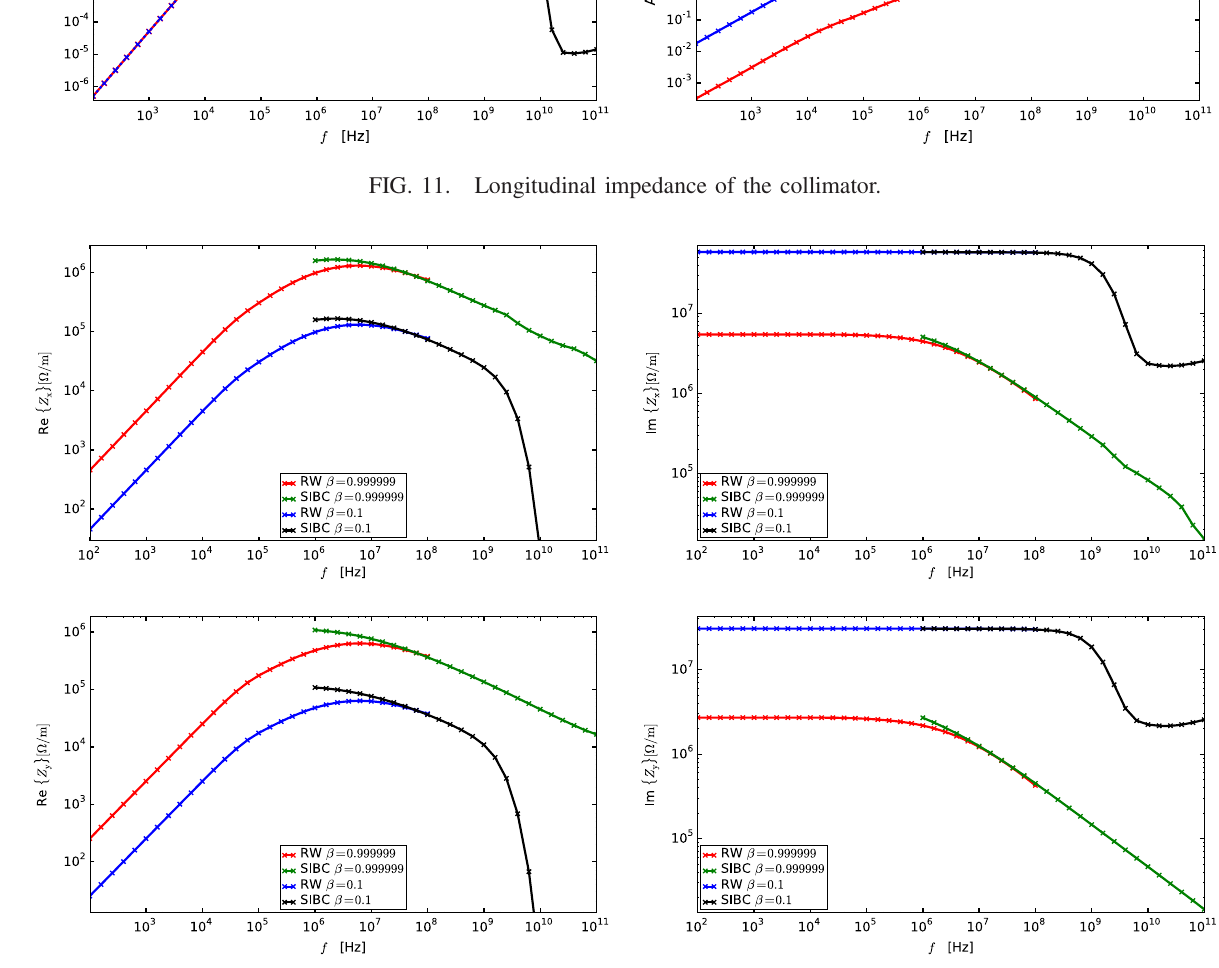
FIG. 12. Transverse impedance (indirect) of the